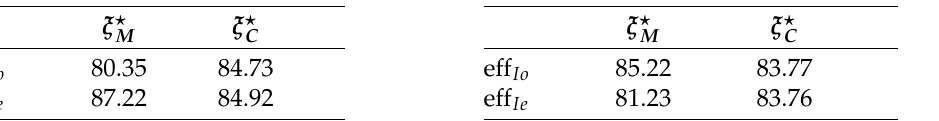
Table 5. Efficiencies of the most balanced solutions of the multi-objective algorithm ξ (cid:63) pound criterion ξ (cid:63) , for each structure of variance, for each of D - and I C